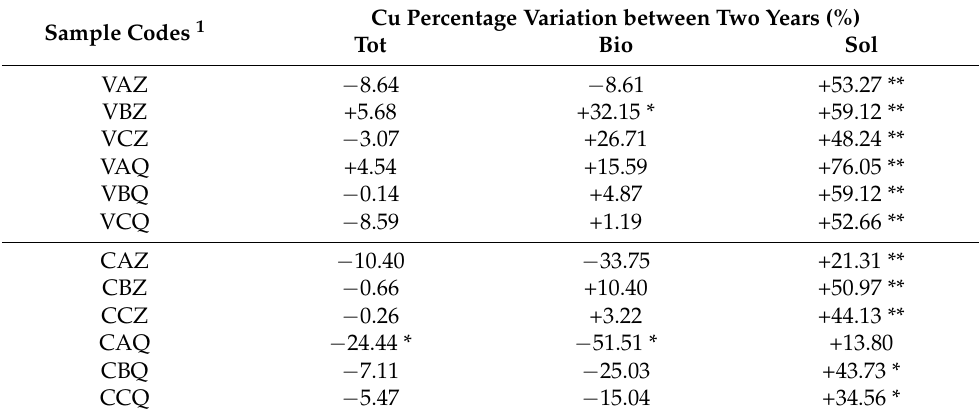
Table 3. Percent of variation in copper concentration in the two years of